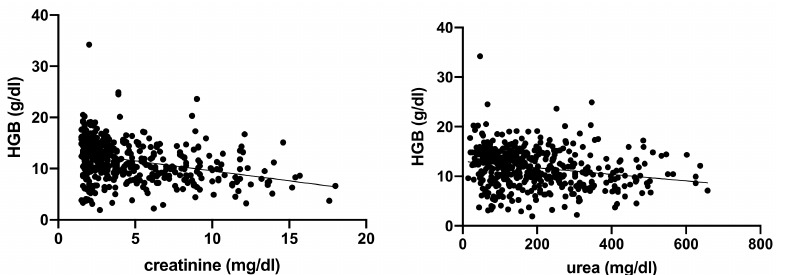
Figure 2. Spearman’s correlation analysis between HCT and serum creatinine and urea. Statistically significant, negative linear correlation ( p < 0.0001; r − 0.3439) between HCT (%) and serum creatinine (mg/dL), and statistically significant negative linear correlation ( p < 0.0001; r − 0.2194) between HCT (%) and serum urea (mg/dL) in the totality of anemic CKD dogs ( n = 302).